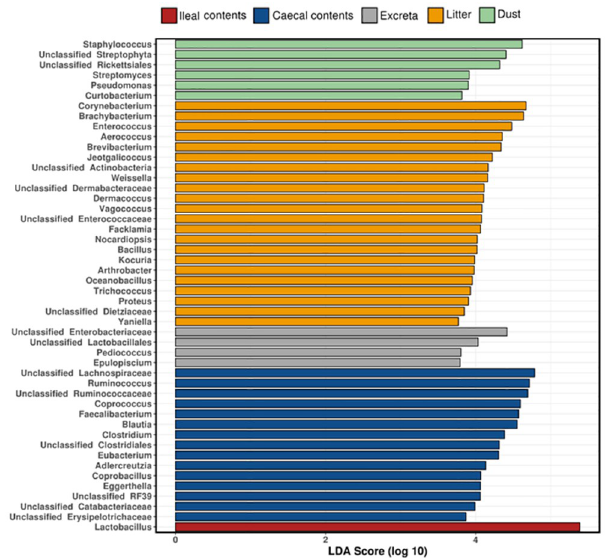
Fig 4. Genera that differentiate sample types identified using linear discriminant analysis effect size (LEfSe).